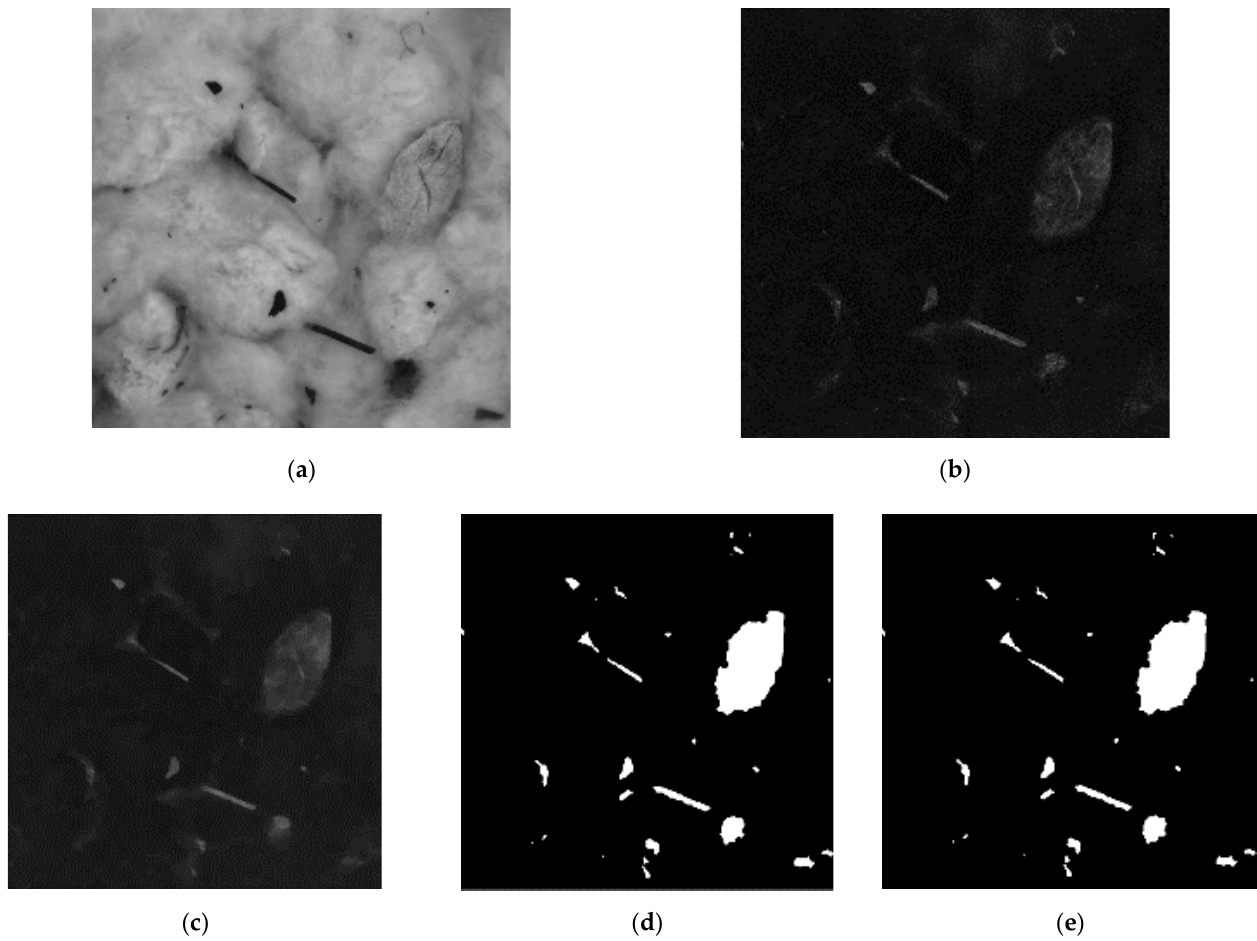
Figure 3. Segmentation of the dark impurity image under S channel. ( a ) The original image; ( b ) extraction of the S channel; ( c ) image enhancement; ( d ) threshold segmentation; ( e ) hole filling.